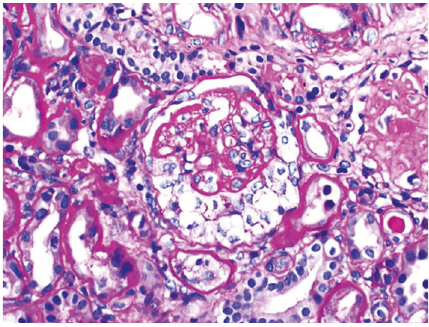
Figure 3: Glomerulus showing intraglomerular sclerosis.